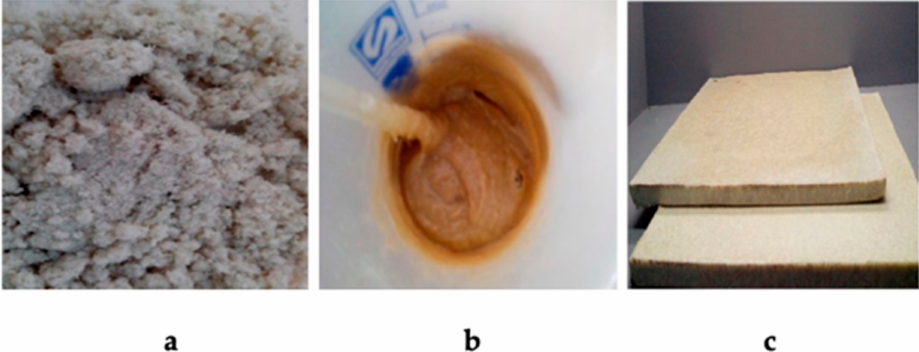
Figure 9. Fiber microparticles ( a ), mixture of polyurethane resin and the fiber microparticles ( b ), and the eco-composite ( c )